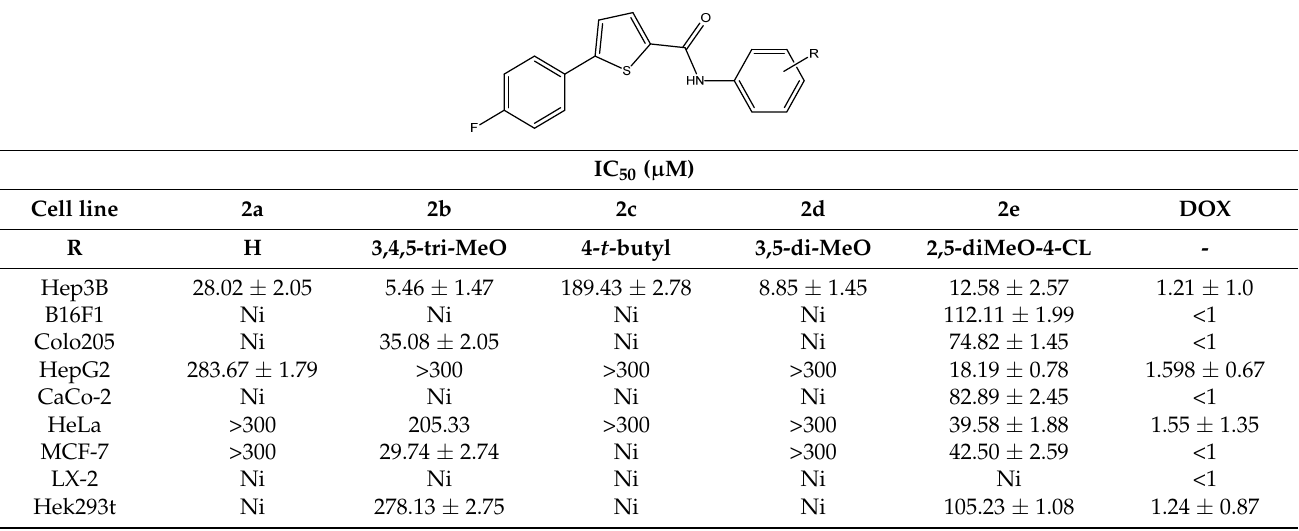
Table 1. IC 50 ( µ M) of phenyl-thiophene-carboxamide compounds ( 2a – 2e ) on several cell lines. Table 1. IC 50 (µM) of phenyl-thiophene-carboxamide compounds ( 2a – 2e ) on several cell